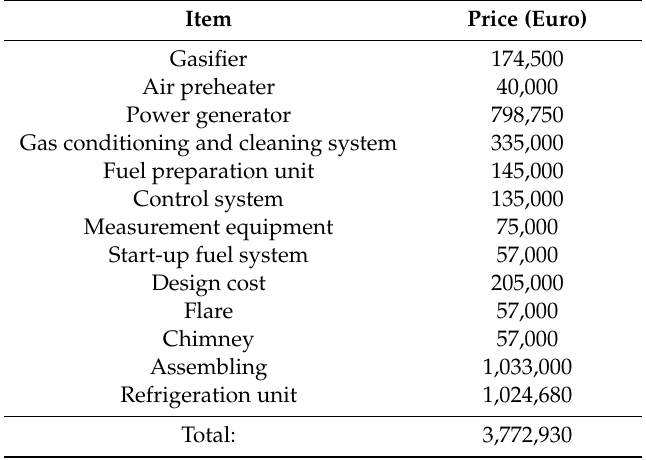
Table 1. Example of investment costs of the proposed semi-industrial power